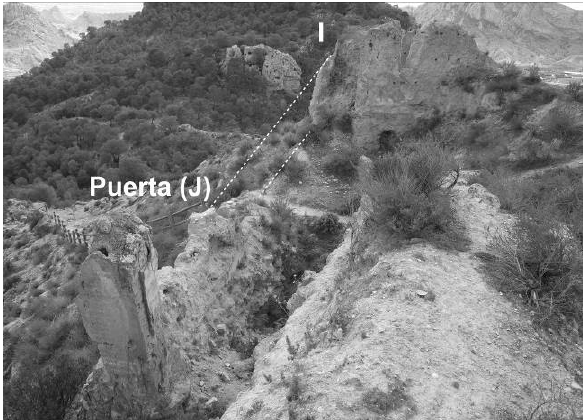
Figure 5. View of the ensemble composed of Tower I and Gate